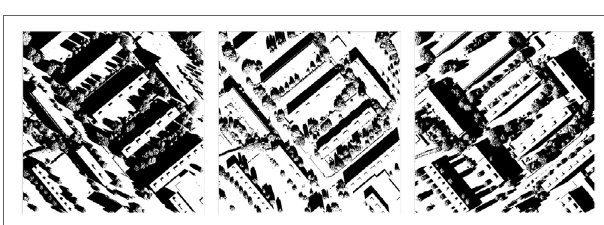
FIGURe 4 | Calculated shadows for an area of Geneva at three times of the day (September